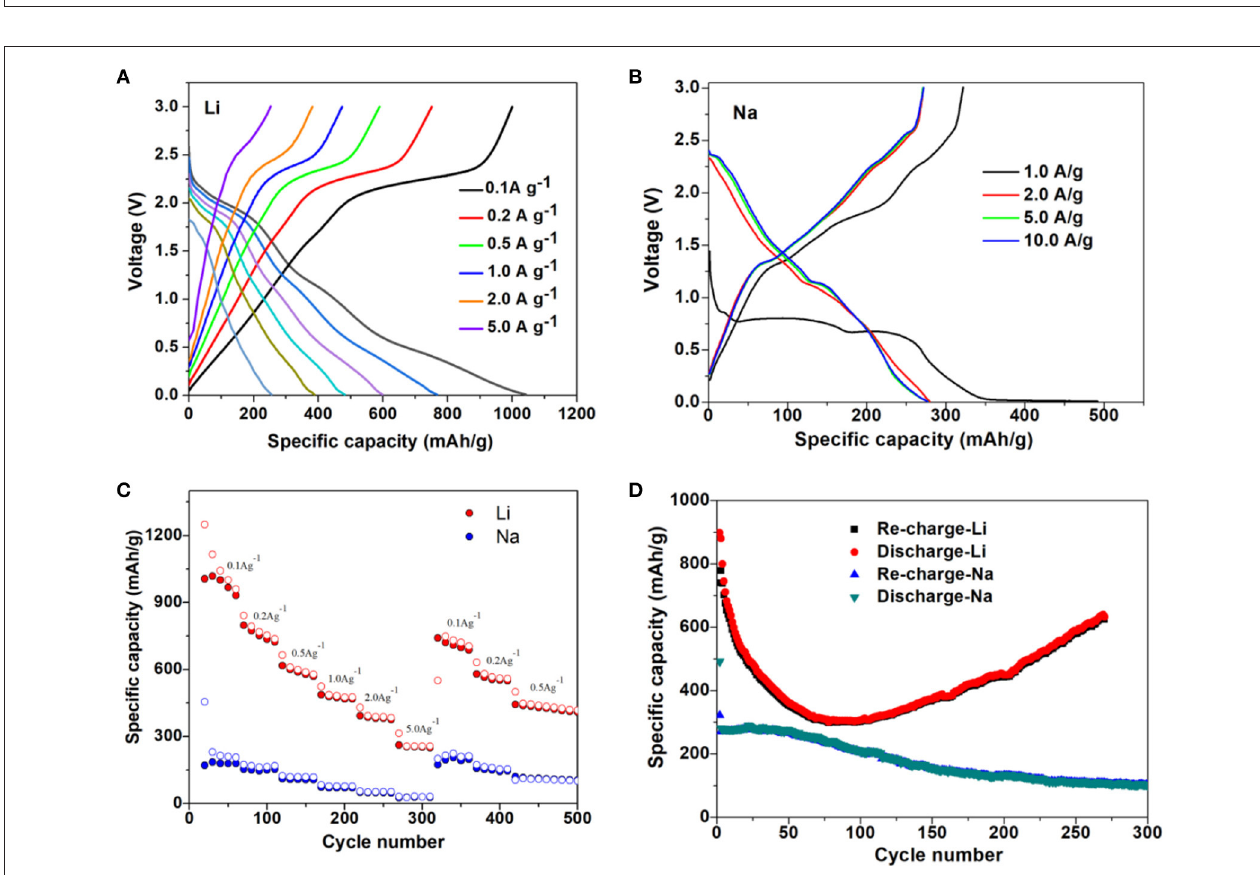
was in accordance with the reported previously (Hao et al., 2018; Chen et al., 2020). These results indicated that the semiconductor MoS 2 may be transformed into metal during the insertion of Li and Na ions, while the properties